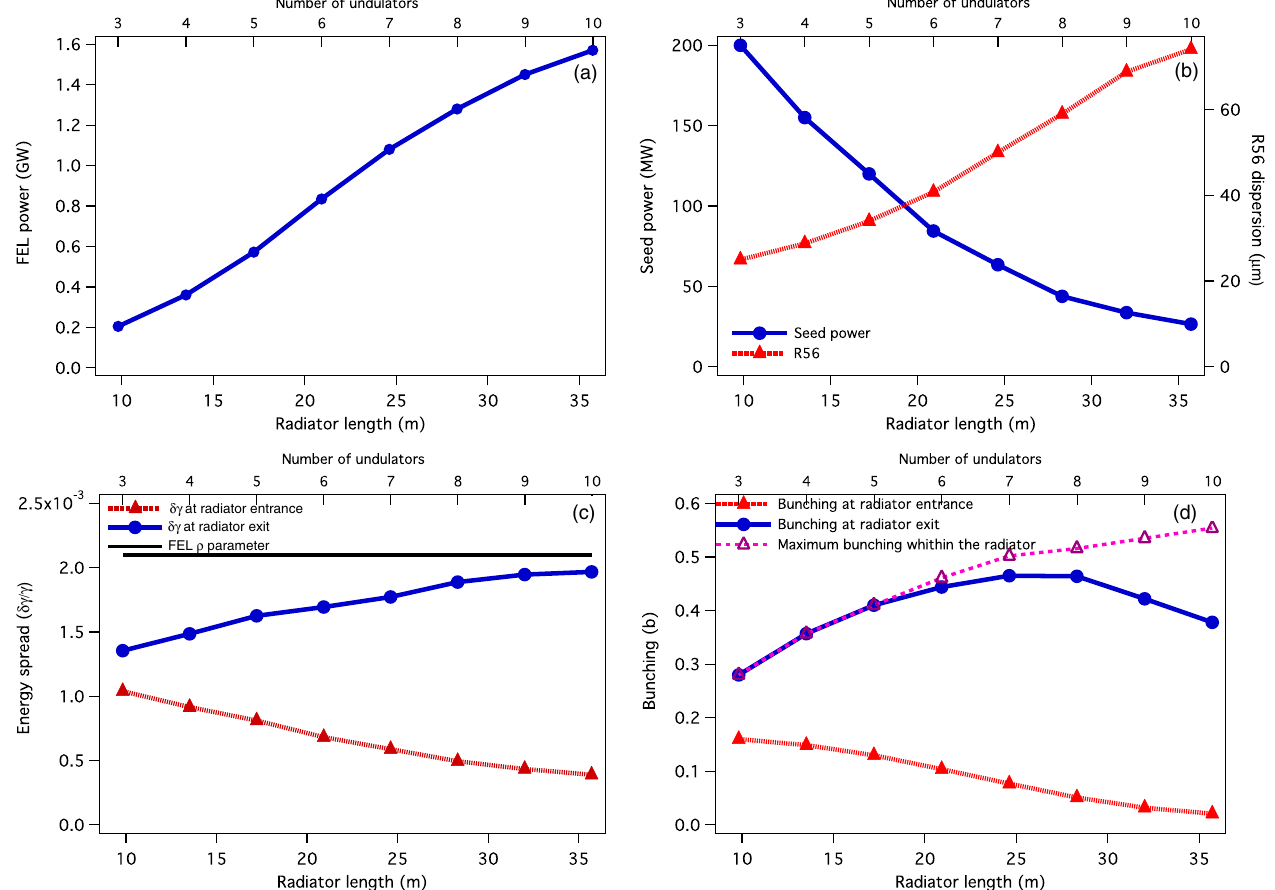
FIG. 3. (a) Maximum power obtained from HGHG at 20 nm using the electron beam with 500 A of peak current as a function of the number of undulators used for the final radiator. (b) Optimized values for seeding power (blue) and dispersive section strength (red) for maximizing the output power for each radiator length. (c) Normalized energy spread of the beam at the radiator entrance (red) and exit (blue), for comparison the FEL (cid:2) parameter is also plotted. (d) Bunching of the electron beam at the FEL wavelength at the radiator entrance (red) and exit (blue); the maximum value of the bunching achieved within the radiator (purple) is also